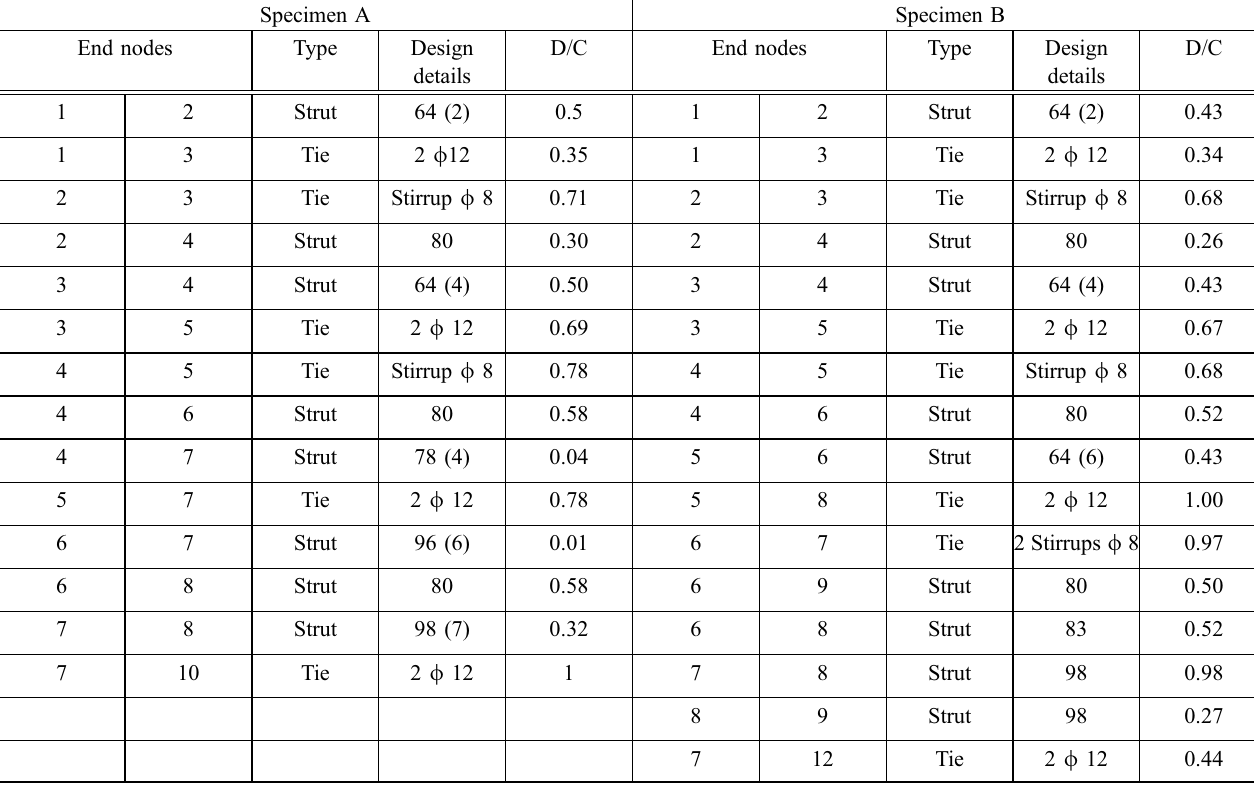
Table 2 Member dimensions, stress limits and reinforcement provided for both the S&T models presented in Fig. 3. Specimen